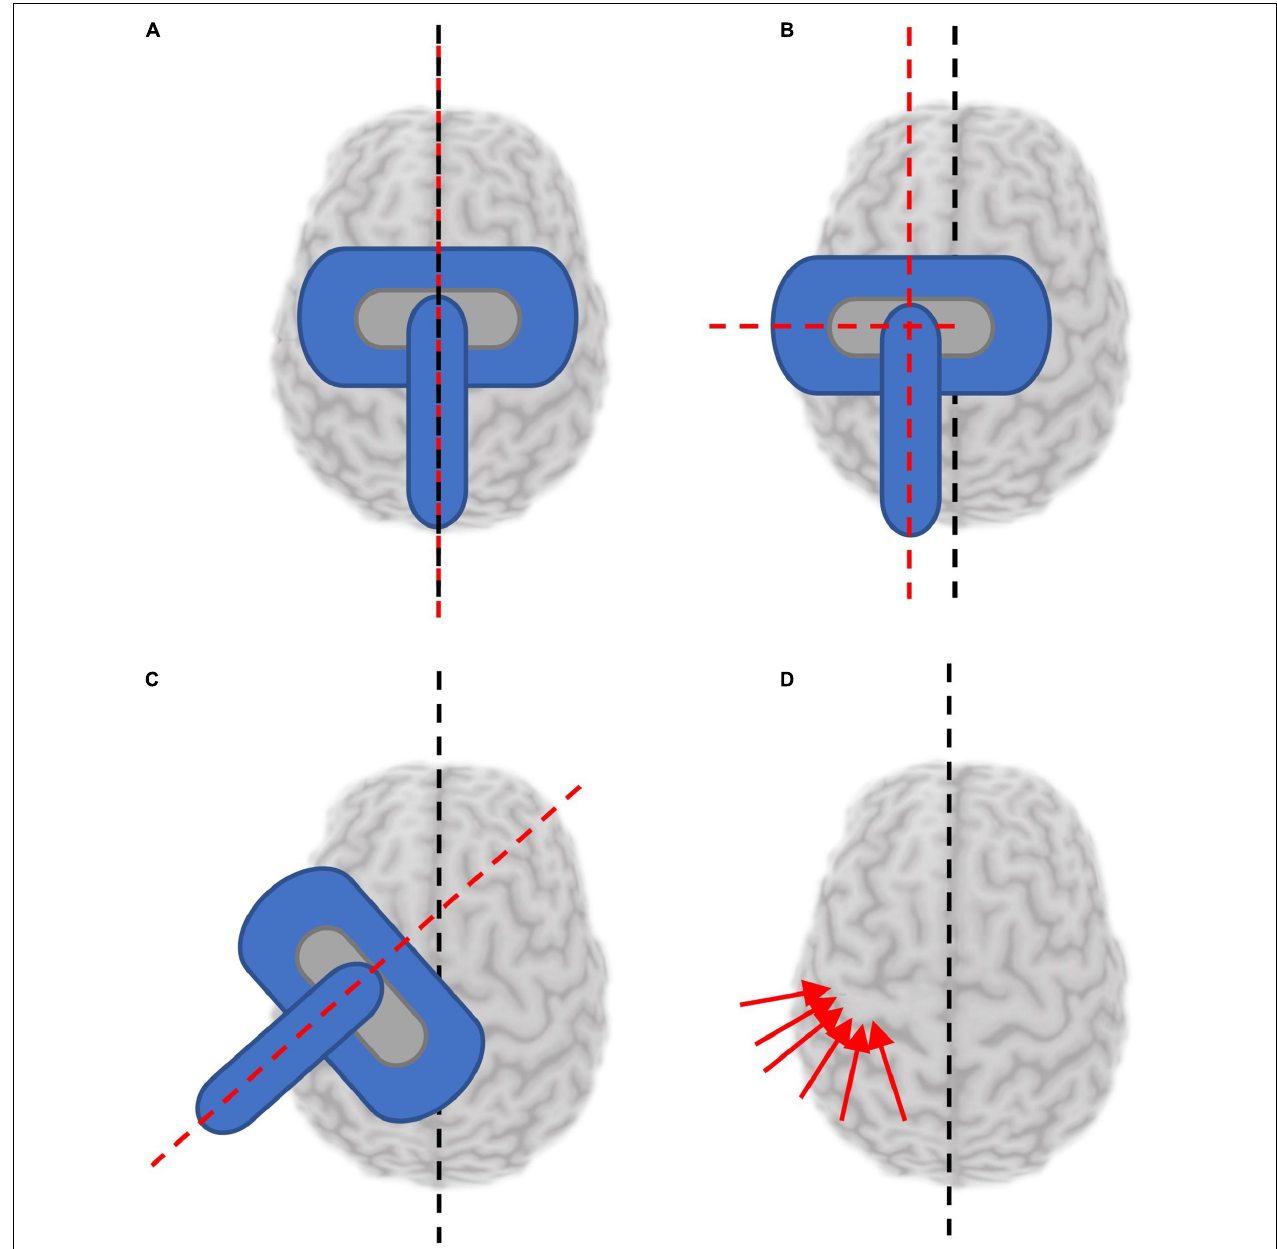
FIGURE 3 | Reported coil orientations used for mapping. Black dashed line denotes orientation of presumed interhemispheric fissure. Red dashed lines or arrows denotes orientation of the TMS coil handle. (A) Coil coincident with and parallel to the sagittal plane. (B) Coil held parallel to the sagittal plane, at a distance from the interhemispheric fissure. (C) Coil held at an angle deviated from the parallel fissure (generally 45 ◦ ). (D) Sulcus aligned mapping involves aligning the coil to be tangential to the sulcus at each stimulated